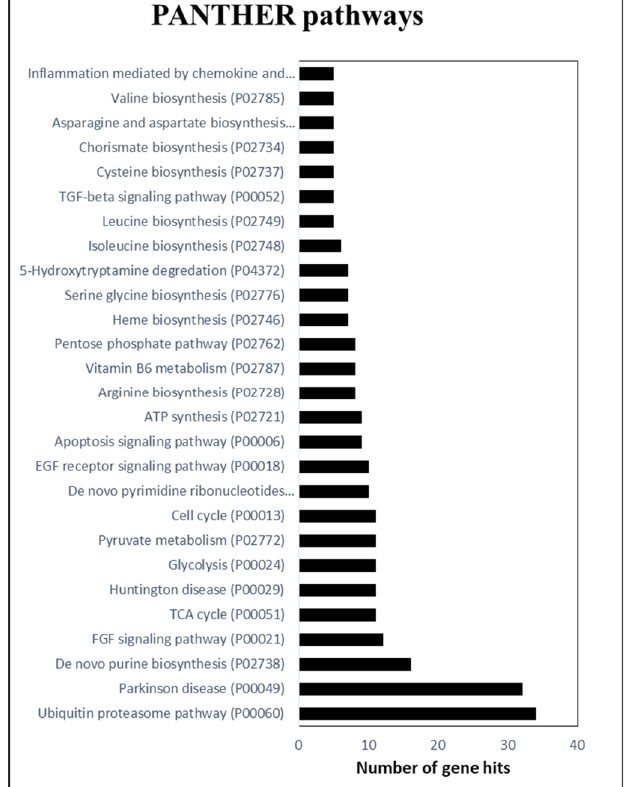
Figure 5. GO pathway categorization of the tuber proteome in the current study using PANTHER tool. Figure represents pathway categories to which 5 or more JA tuber gene hits were detected.